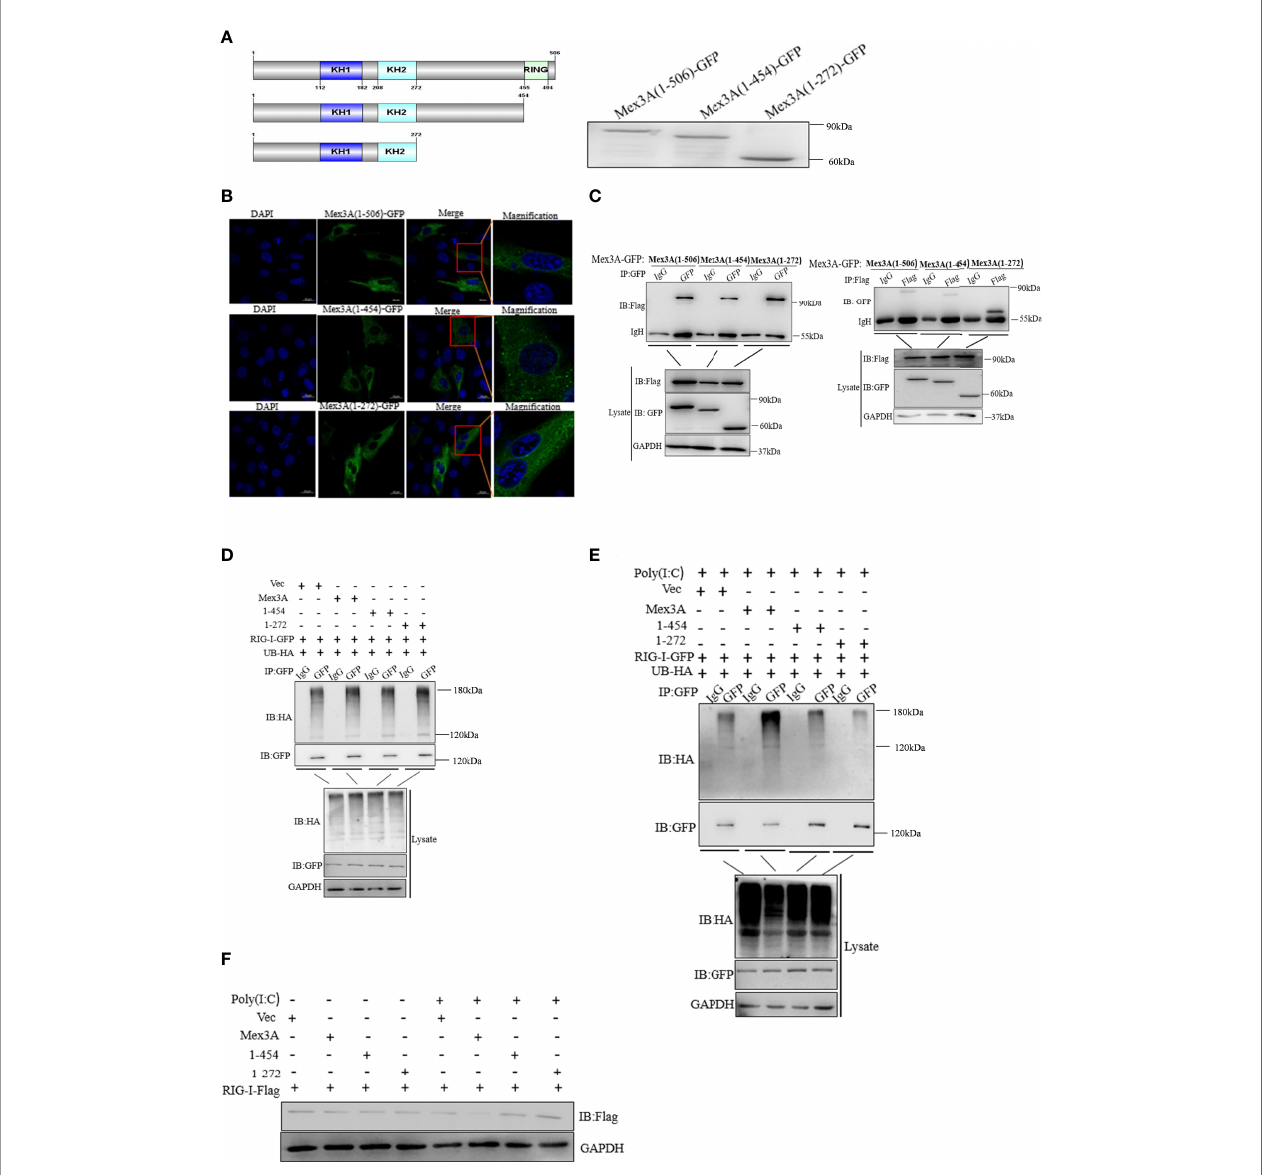
FIGURE 6 | Mex3A promotes ubiquitination of RIG-I by the RING domain. (A) A schematic presentation and expression on full-length Mex3A and its mutants. (B) Subcellular localization analysis of Mex3A and its mutants. The samples were tested and the photographs were taken under 63× oil immersion using a Zeiss confocal microscope. The bars show 10 m m (C) Domain mapping of the Mex3A and its mutants with RIG-I. The CO cells were transfected with either Mex3A- GFP or the indicated Mex3A mutant plasmids (2.5 m g) and RIG-I-Flag plasmids (2.5 m g). Co-immunoprecipitation and Western blotting were performed with the indicated antibodies. (D, E) CO cells were transfected with the indicated plasmids. The cells were treated with poly(I:C) for 6 h in panel (E) The ubiquitination of RIG-I was analyzed by immunoprecipitation with anti-HA, followed by Western blotting analysis using the indicated antibodies used in Figures 4C, D . (F) The full-length of Mex3A promotes the degradation of RIG-I. CO cells were transfected with the indicated plasmids. The cells were lysed and analyzed by Western blotting with anti-Flag antibody; GAPDH antibody was used as the internal control. The results are based on three independent